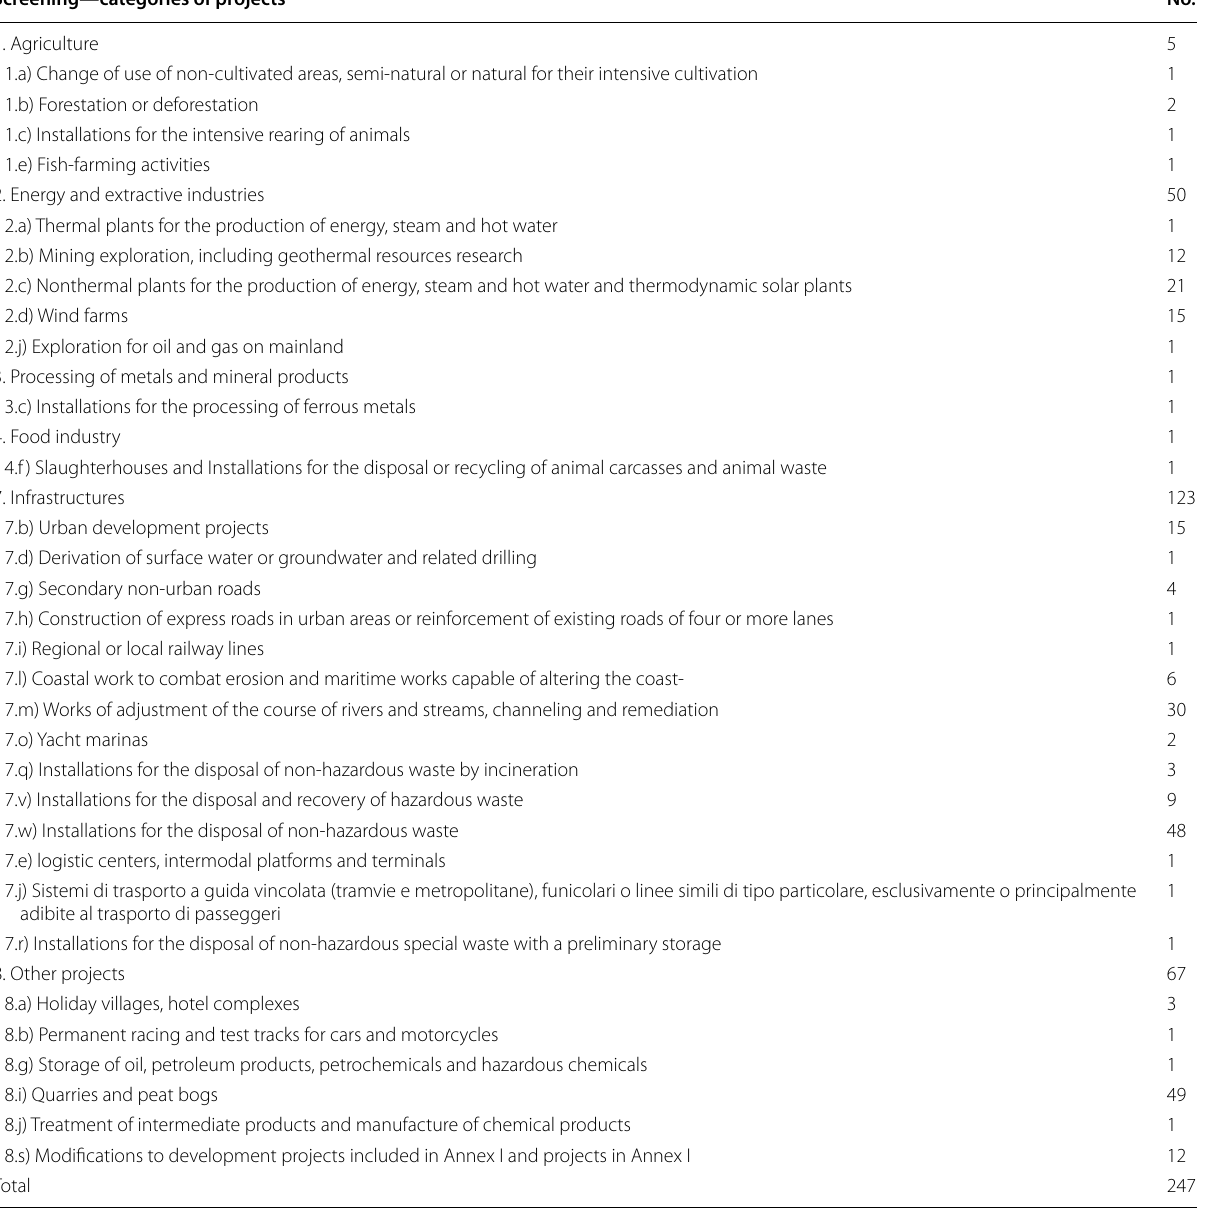
Screening—categories of